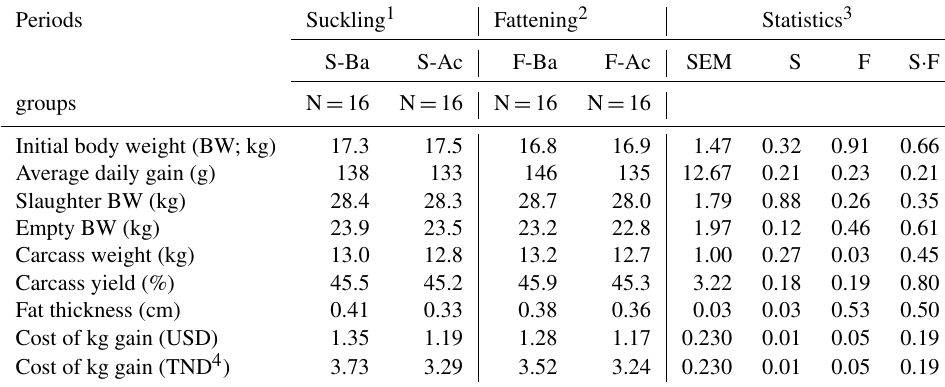
Table 4. Non-carcass components: weight and proportion in empty body weight (EBW). Periods Suckling 1 Fattening 2 Statistics 3 Groups S-Ba S-Ac F-Ba F-Ac